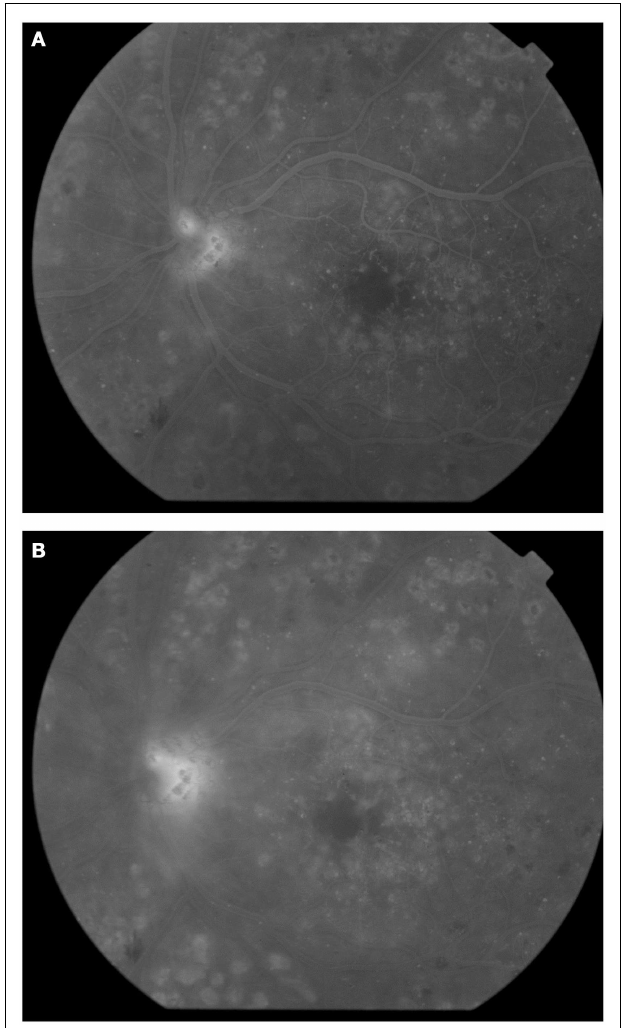
FIGURE 2 | Fluorescein angiography obtained from the left eye of a patient with diabetic macular edema and PDR . Note drop out of perifoveal capillaries (A) with late leakage (B) and leakage from neovessels at the disc (A,B)